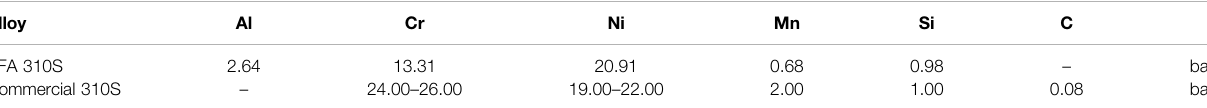
TABLE 1 | Chemical composition of test alloys (wt%)